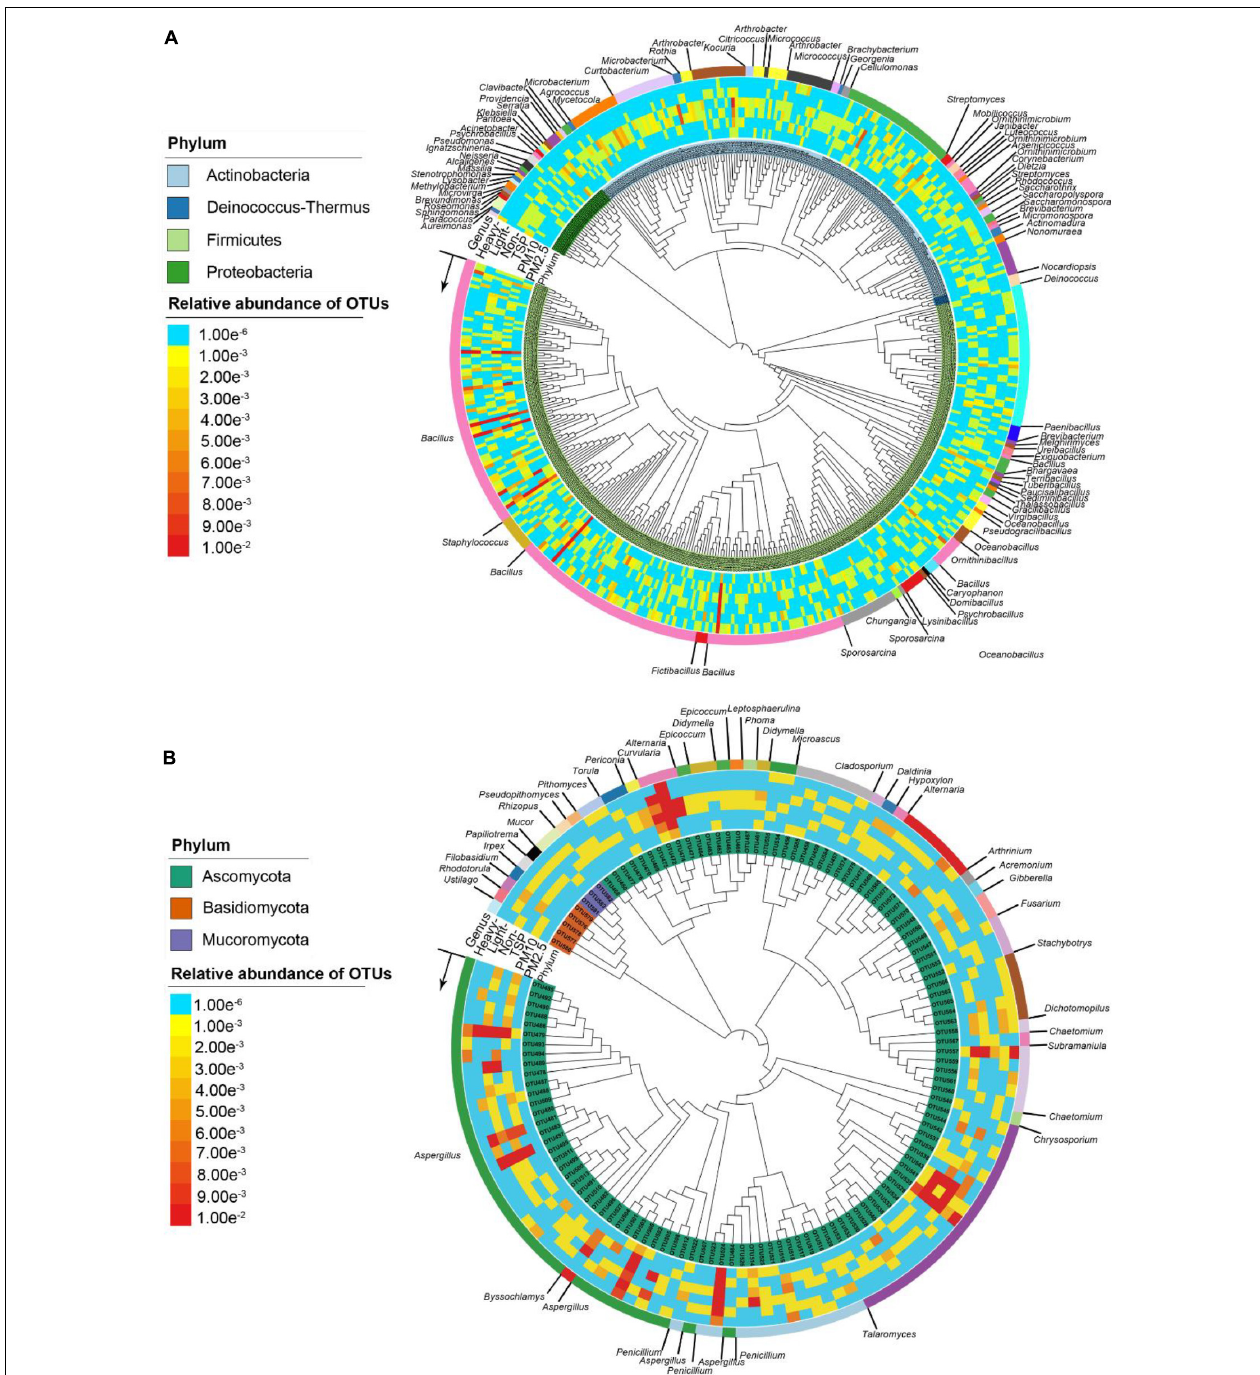
FIGURE 3 | Phylogenetic tree of microbial isolates based on bacterial 16S rRNA sequences (A) and fungal ITS sequences (B) using neighbor-joining methods.